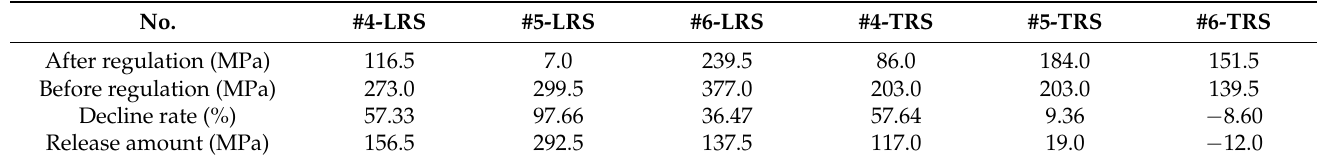
Table 8. Peak residual stress changes on the front side of samples #4, #5, and #6.